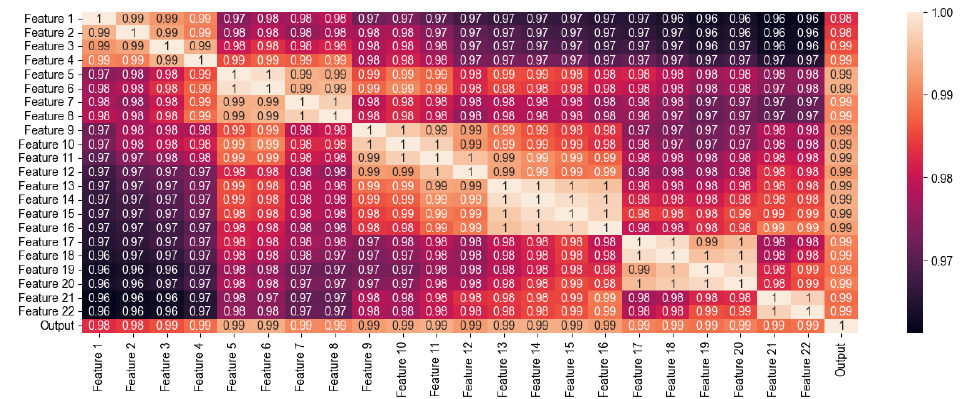
Figure 1. Heat Map of Correlation Matrix between each of the input features and the output